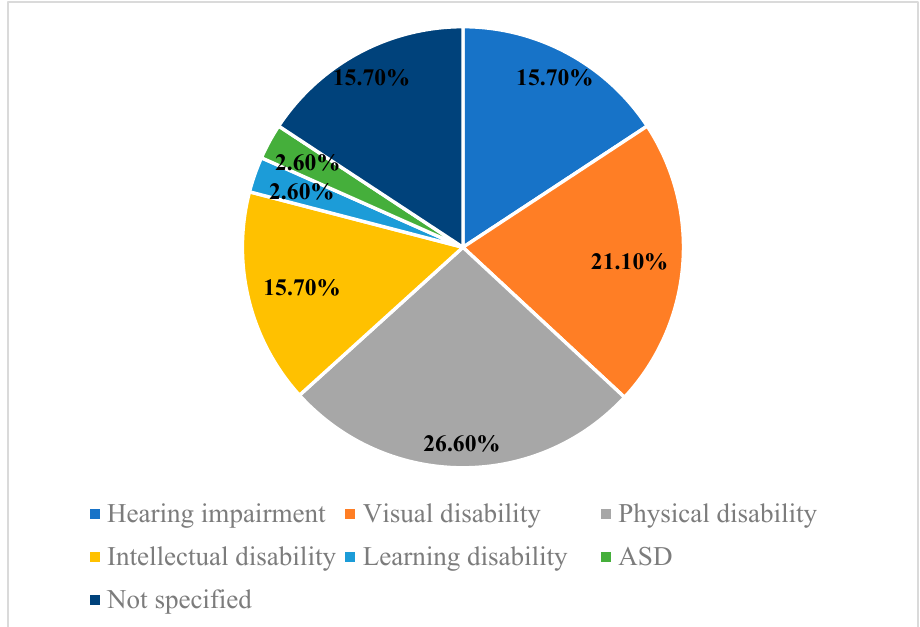
Figure 4. Studies by type of disability.